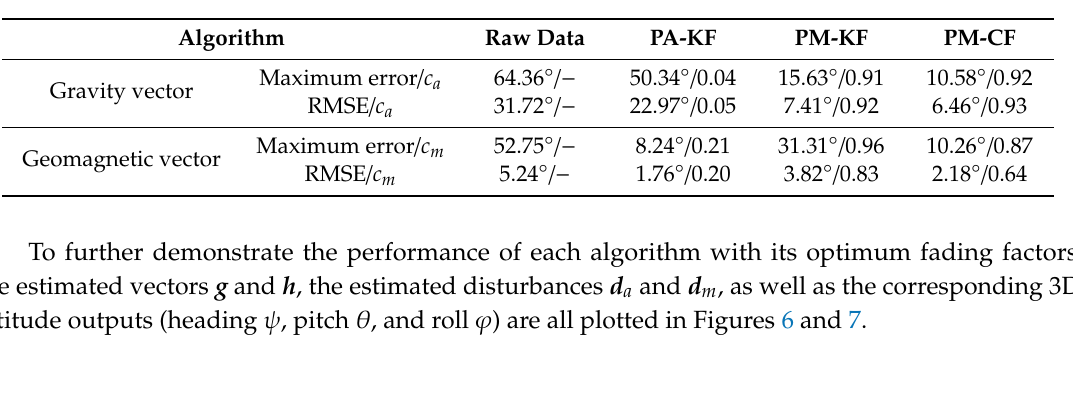
Table 1. The best performance of each